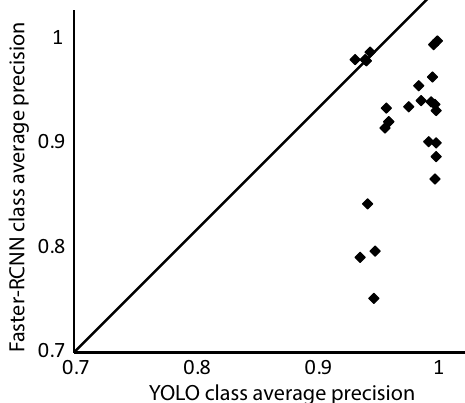
Figure 3. A comparison between the average class precision of YOLO and faster R-CNN detectors. Markers of the scattered diagram represent the classes of both detectors with a specific anchor box. Classes below the diagonal indicate that the YOLO detector outperforms the faster R-CNN detector.